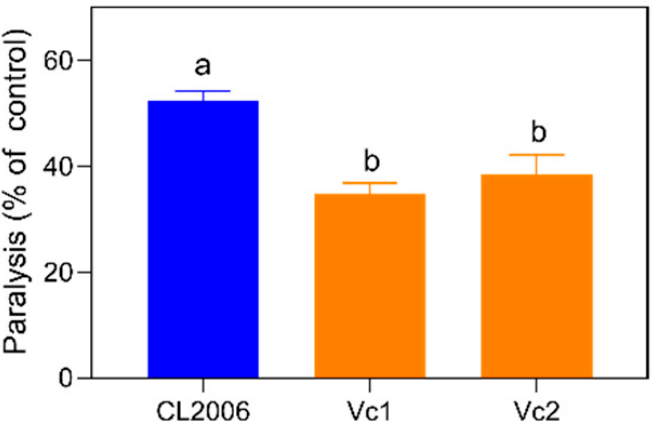
Figure 1. Paralysis rate in CL2006 exposed to Vc. Letters (a, b) in each column indicate statistically significant difference ( p < 0.001).